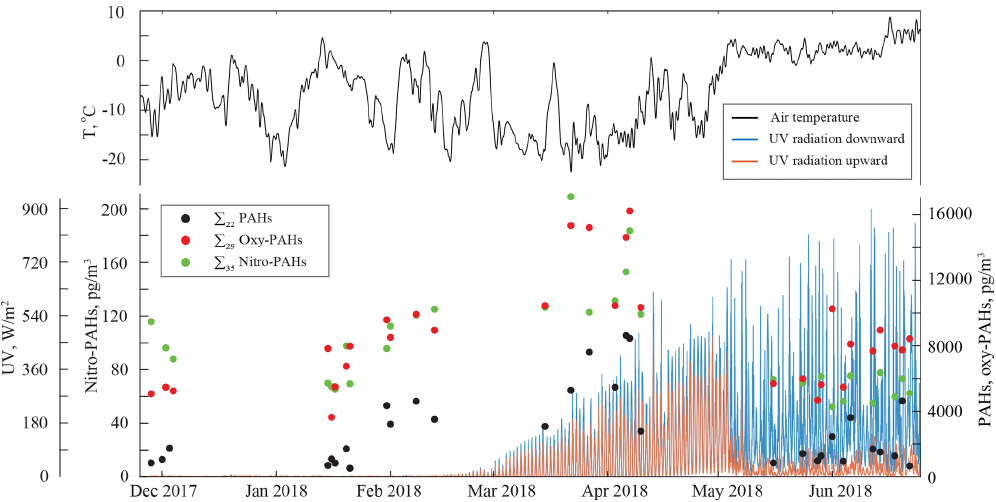
Figure 1. Atmospheric temperature, UV radiation, and daily total (gaseous + particulate) concentrations of (cid:54) 22 PAHs, (cid:54) 29 oxy-PAHs, and (cid:54) 35 nitro-PAHs in the urban air of